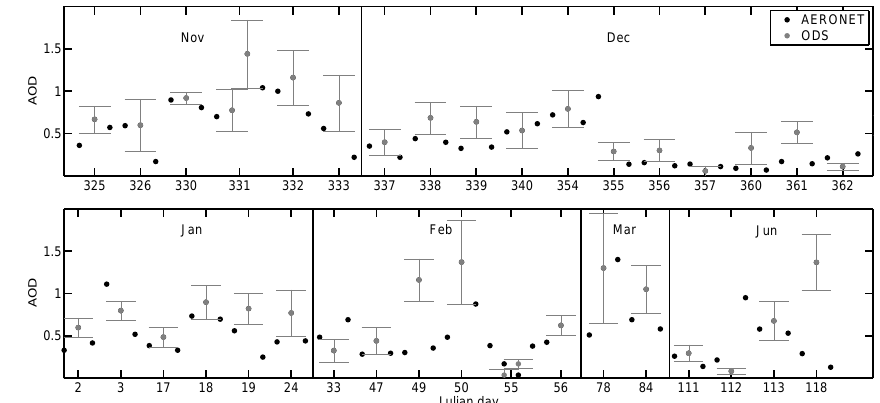
Figure 17. AOD derived from ODS red channel at nighttime (grey dots with error bars) between November 2004 and October 2005, and AERONET AOD (black dots) at 870nm at 16:00 and 07:00UTC of the next day for each ODS measurement.